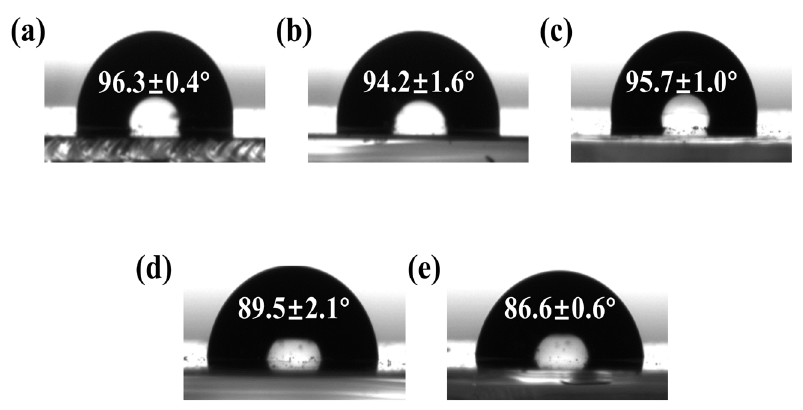
Figure 2. The water contact angle image: ( a – c ) The PBDT-IID2, PBDT-IID3, and PBDT-IID4 film formed with chlorobenzene, respectively; ( d ) The PBDT-IID4 film formed with methyl tetrahydrofuran; ( e ) The PBDT-IID4 film formed with toluene.